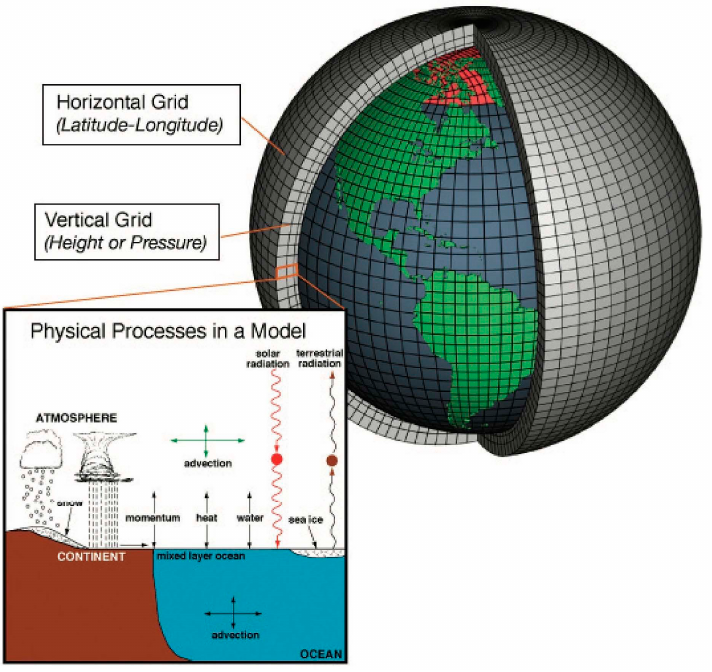
Figure 2. Schematic illustration of a global circulation model. From National Oceanic Atmospheric Association (NOAA) [21].